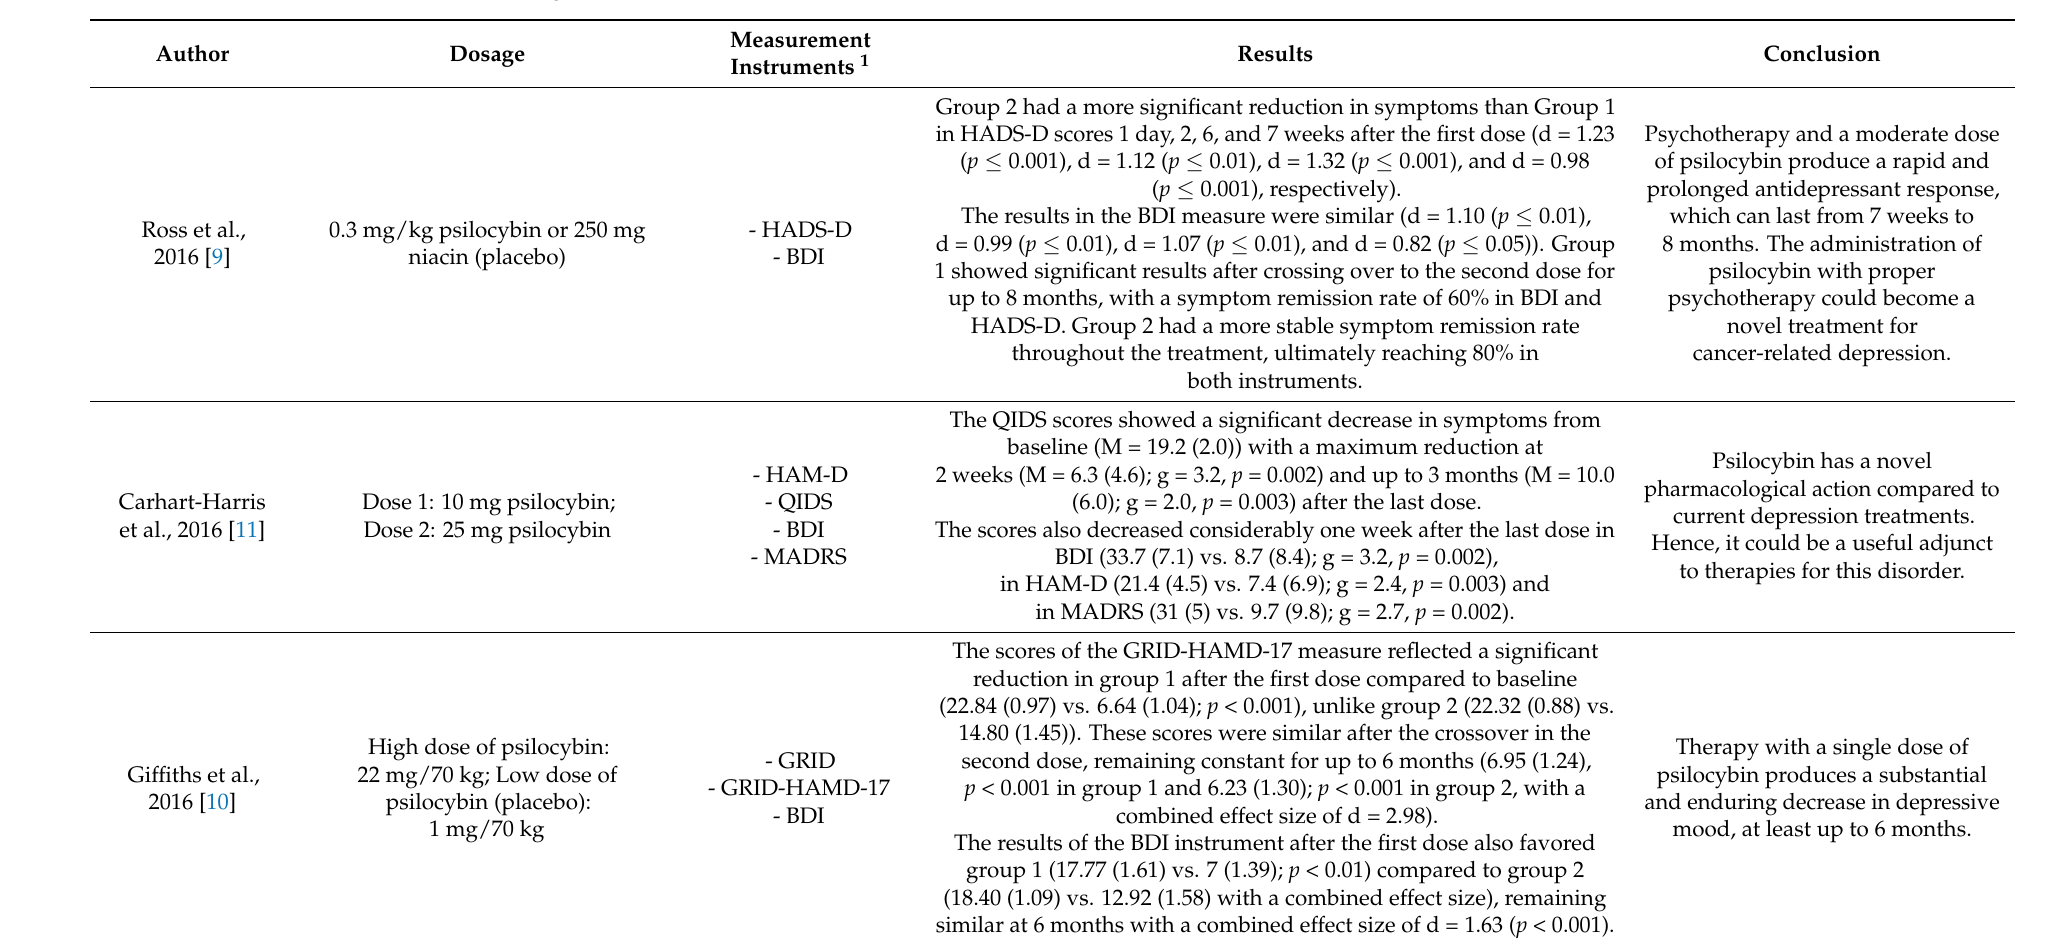
Table 2. Dosage, measurement instruments, results, and conclusions of the